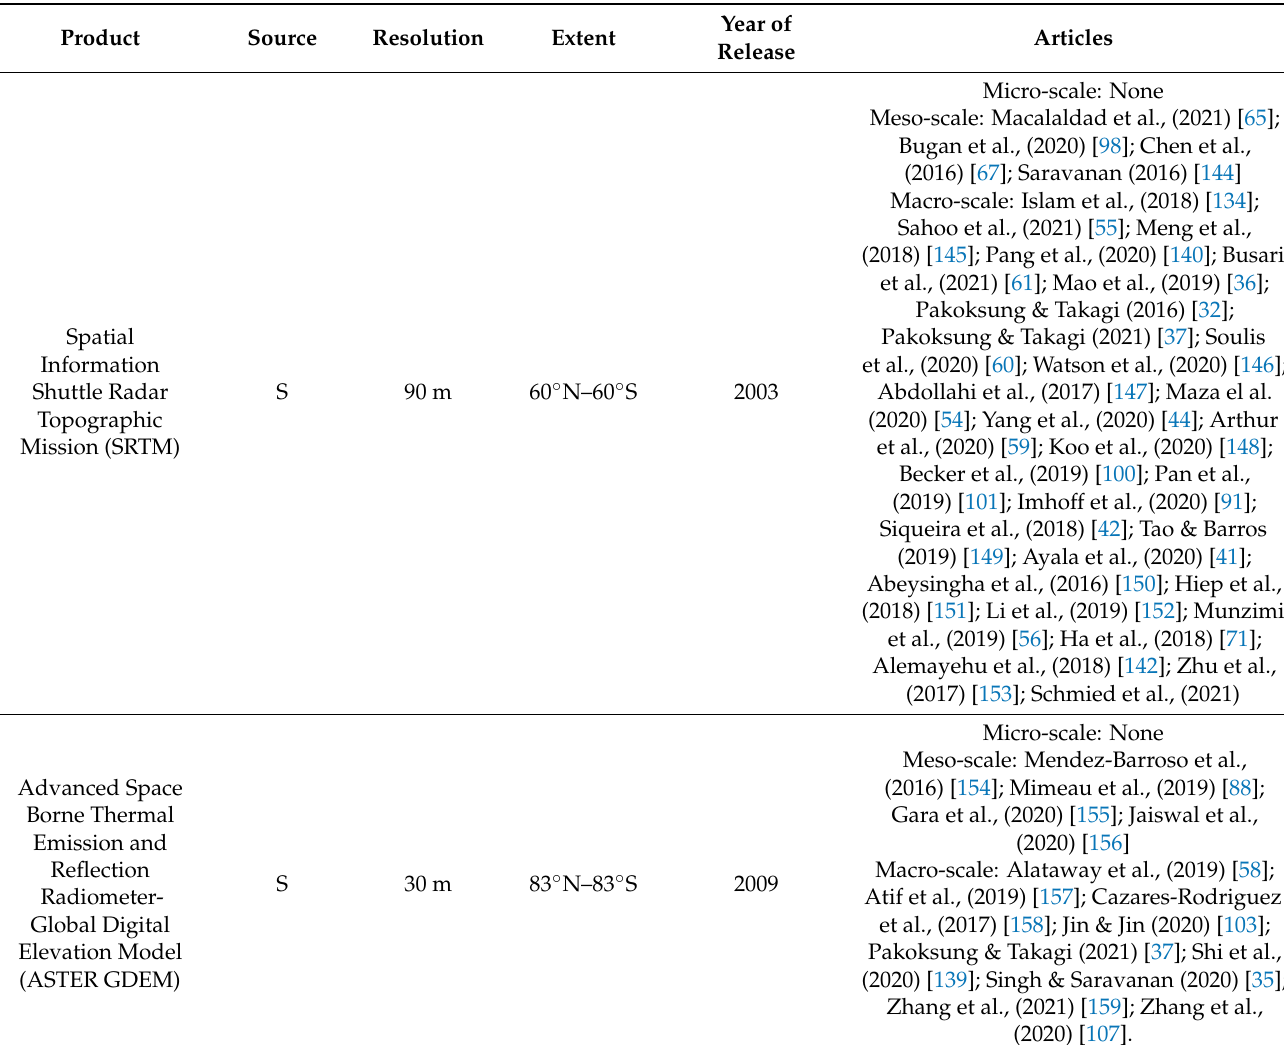
Table A2. Digital Elevation Model datasets used in reviewed